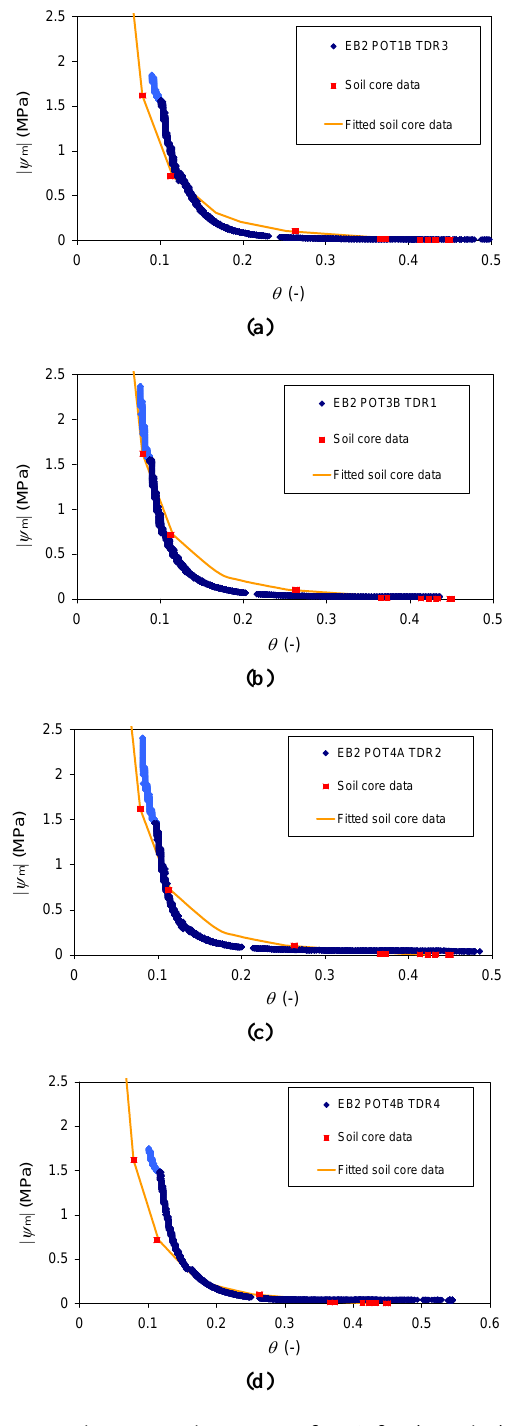
Fig. 11. Moisture retention curves of EB2 for the paired poly- mer tensiometers (POTs) and time domain reflectometers (TDR) together with gravimetric data from soil cores, and Van Genuchten fitted retention curve. The minus sign of the matric pressure values ( ψ m (MPa)) has been